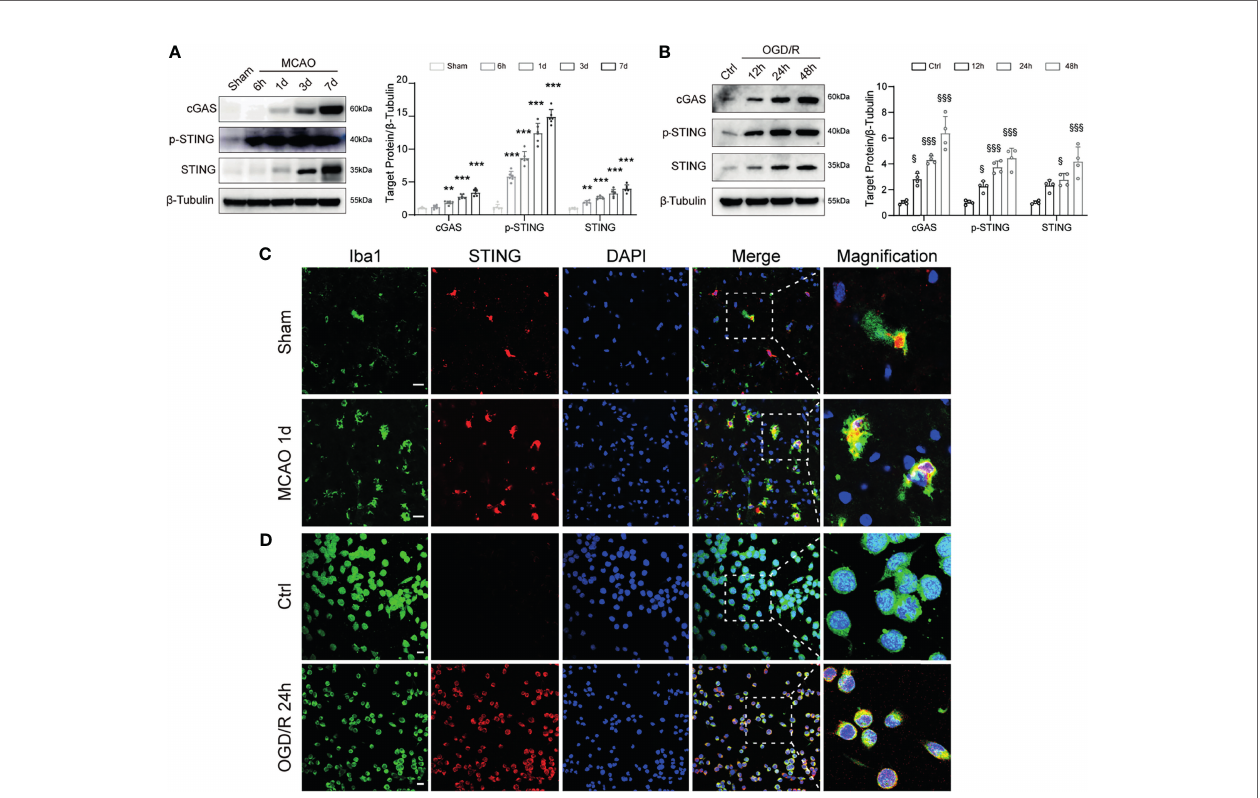
FIGURE 1 | Temporal expression and cellular localization of STING following ischemic stroke. (A) Western blot and quantitative analysis of cGAS, p-STING and STING at 6 h, 1d, 3d, and 7d after MCAO. n = 6. (B) Western blotting showing cGAS, p-STING and STING expression at 12 h, 24 h, 48h after reoxygenation. n = 4. (C, D) STING/Iba1 double immunostaining in Sham and MCAO mice 1d after reperfusion and in Control and OGD/R BV2 microglia 24h after reoxygenation. STING signal was increased after I/R injury both in vivo and in vitro . n = 4. Data are expressed as mean ± SD. ** P < 0.01, *** P < 0.001 vs Sham group. § P < 0.05, §§§ P < 0.001 vs Ctrl group. Scale bar = 20 m